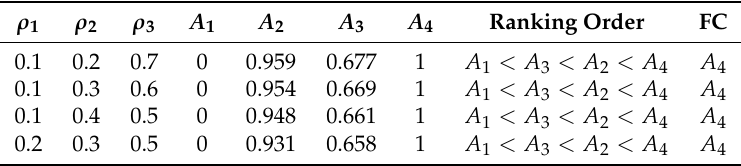
Table 10. Strict risk lover.